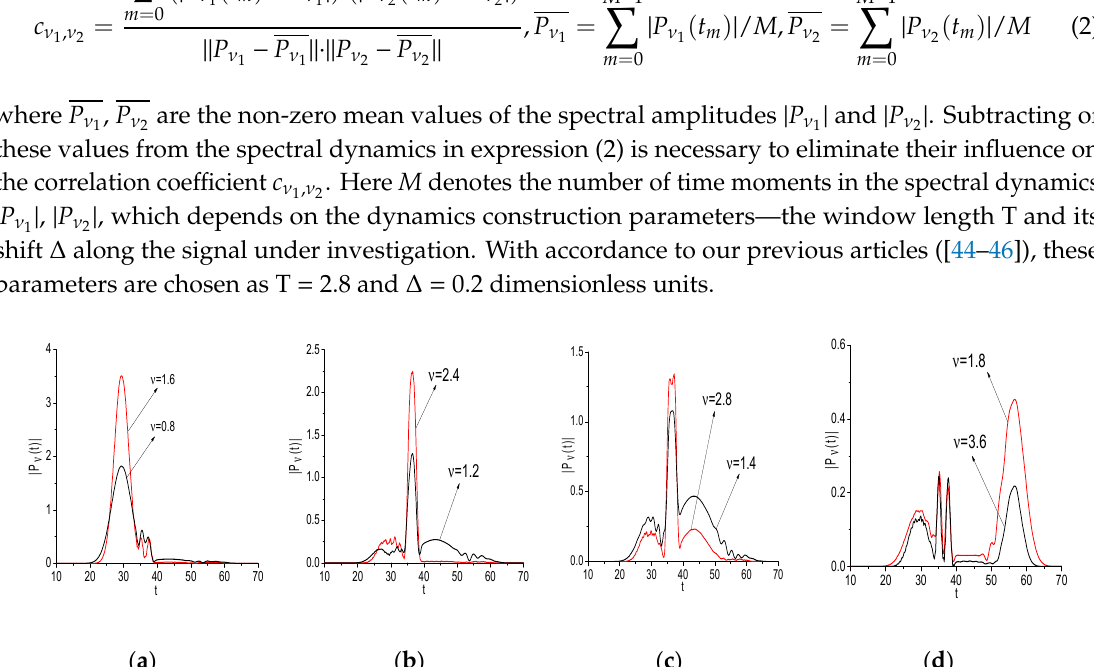
Figure 3. Evolution of the spectral amplitude modulus at the basic frequency ν base = 0.8, 1.2, 1.4, 1.8 (black line, signal E inc ( t ) ) and doubled frequency ν = 1.6, 2.4, 2.8, 3.6 (red line, signal E inc 2 ( t ) ), as depicted in ( a – d ), respectively.